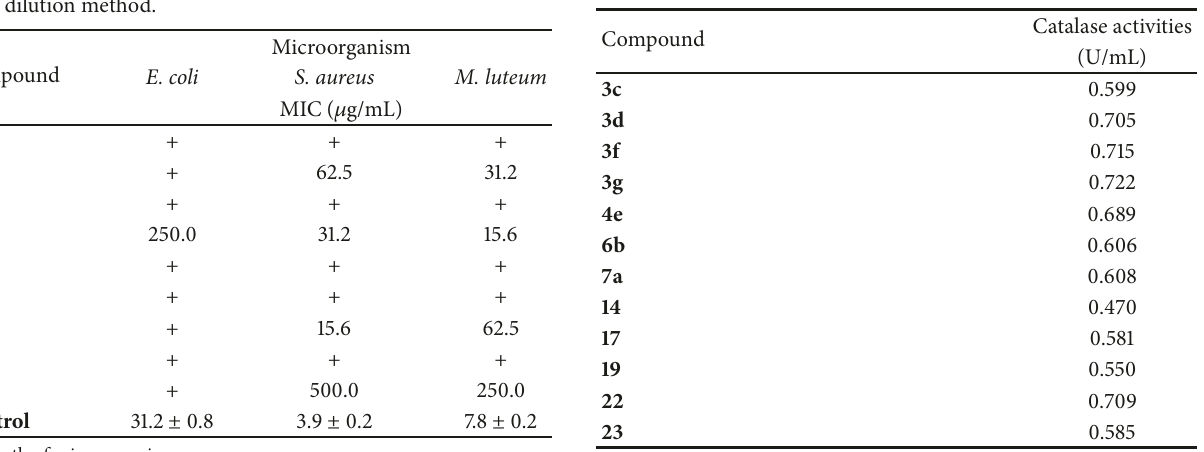
Table 5: Catalase enzyme activities of the